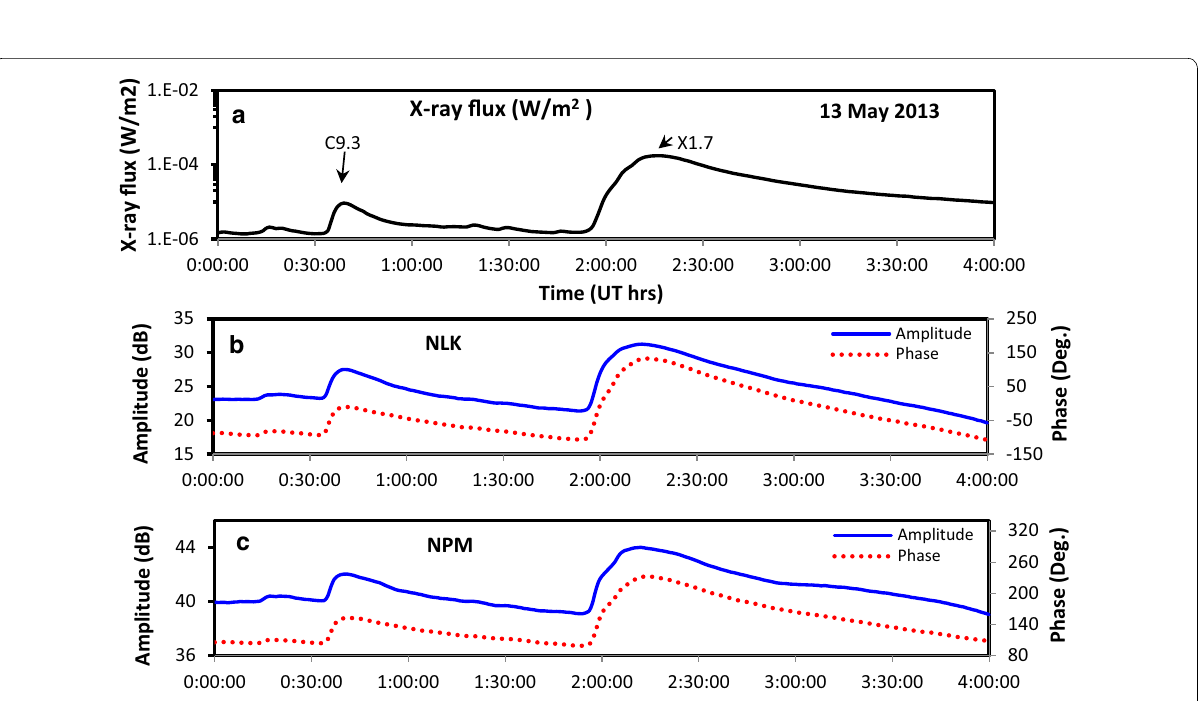
Fig. 3 a Variations in the GOES X-ray flux in W/m 2 during the solar flares of May 13, 2013. b , c Variations in the amplitude and phase of the NLK and NPM signals during the May 13, 2013 solar